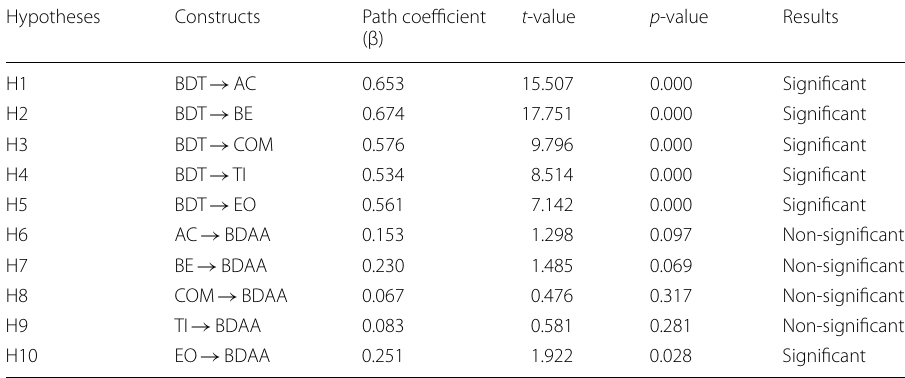
Critical values: t > 1.645; p <